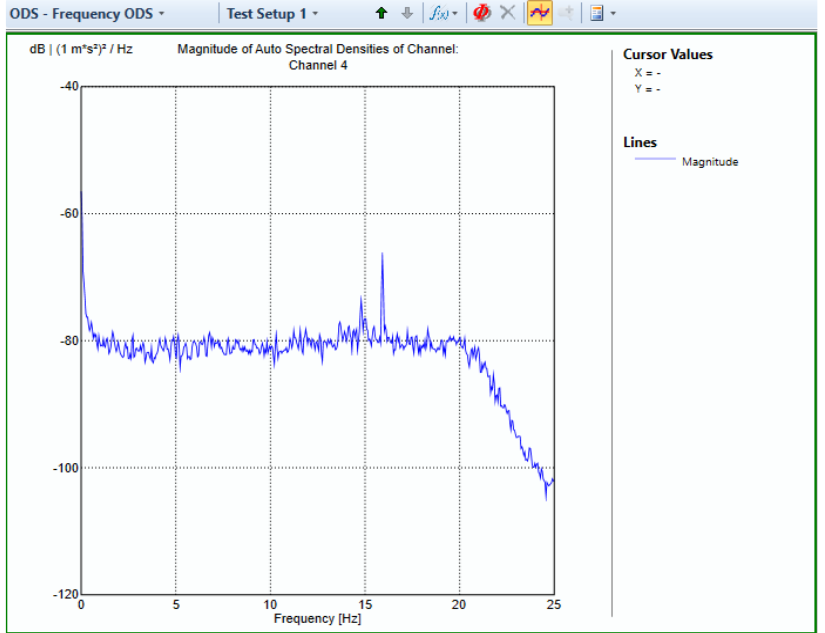
Figure 12. PSD of channel X of Sensor “B” of M1 estimated by FDD using ARTeMIS Modal software.